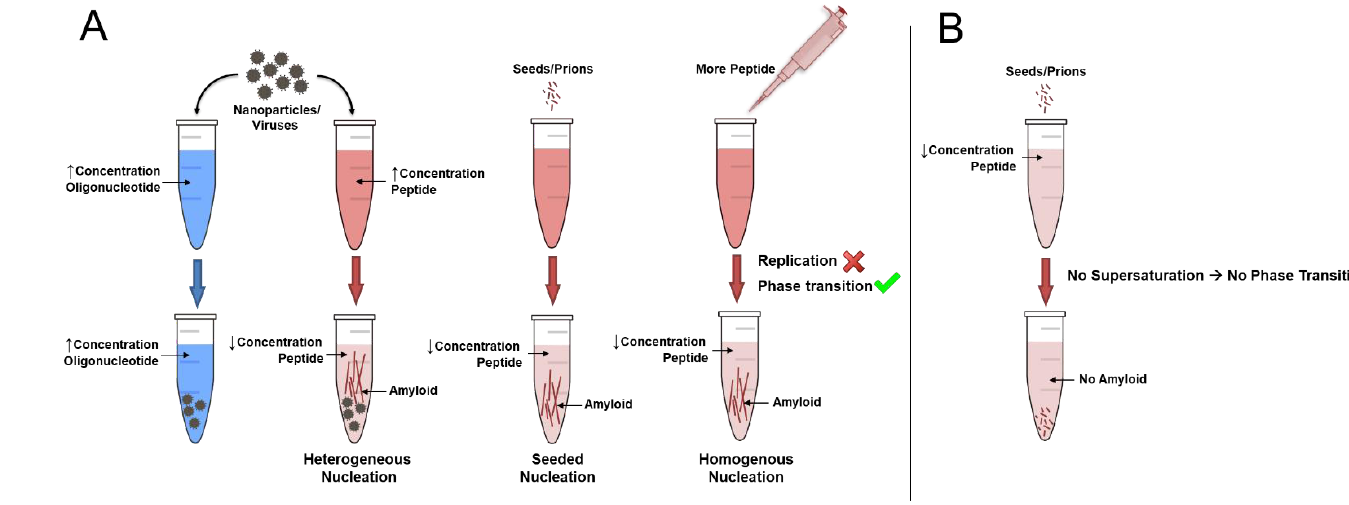
Figure 3. Proteins precipitate, they do not replicate. ( A ). The information to form amyloids is already present in the backbone of any protein sequence. Under supersaturated conditions, any protein can be triggered to precipitate into amyloids by surfaces (HEN), a preformed nucleus (seeding), or increasing the concentration to allow for HON. This is in contrast to DNA replication, which requires a specific template sequence, enzymes and continuous energy input in the form dNTPs. ( B ). Formation of amyloid is dependent on the recipient conditions, not on donor seeds. Thus, adding seeds/prions to proteins in a non-supersaturated condition will not result in amyloid formation, protein unfolding or any kind of templating.